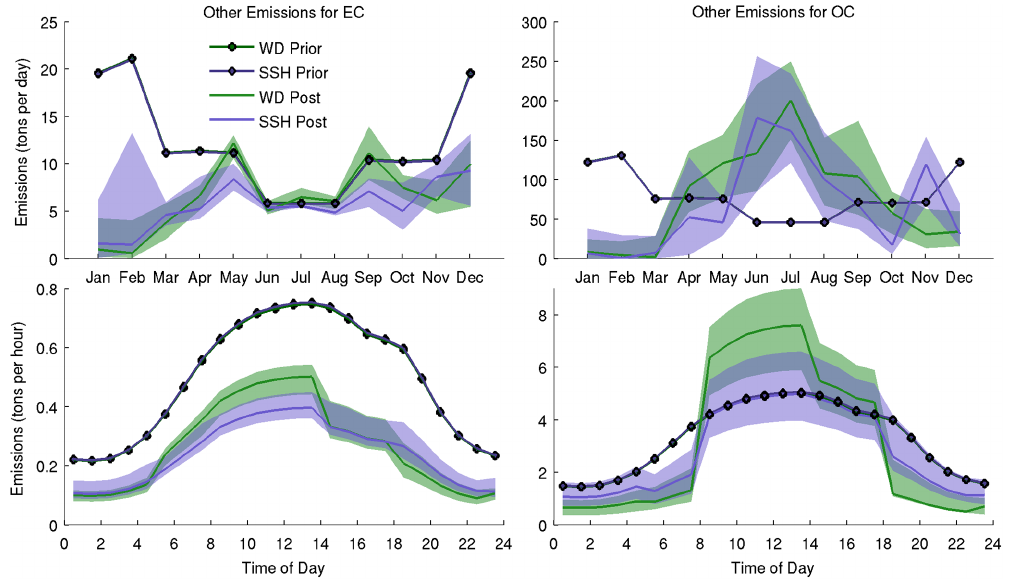
Figure 13. Monthly and diurnal temporal pattern of emissions of EC and OC for “other” emissions by weekday and weekend for the St. Louis region, see Fig.